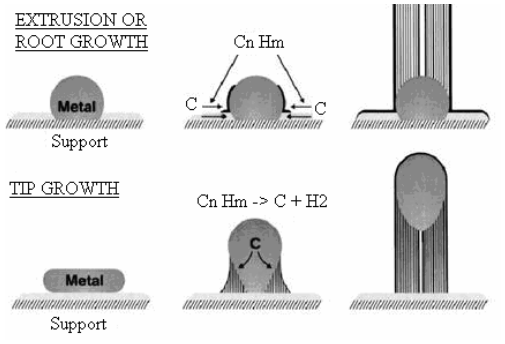
Figure 4 . Probable models for CNT